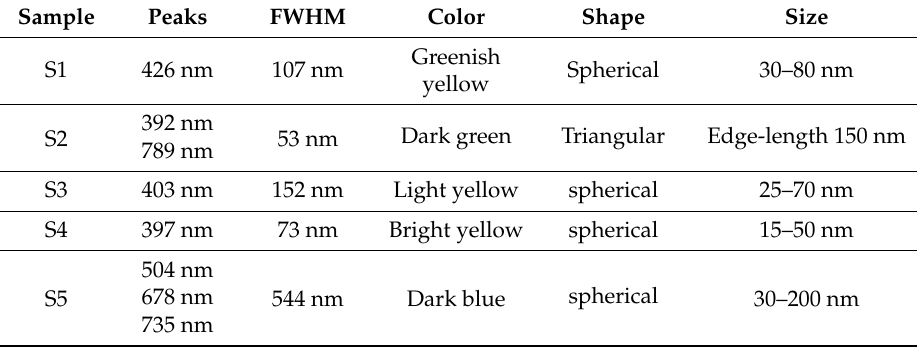
Table 2. Summary of ultraviolet visible (UV-VIS) spectroscopy and scanning electron microscopy (SEM) measurements. (FWHM: full width at half maximum) Sample Peaks FWHM